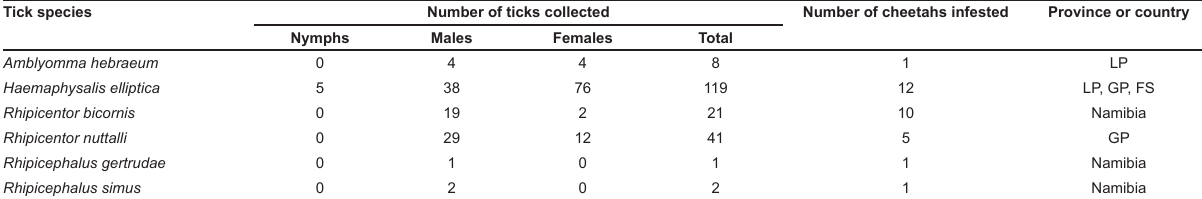
TABLE 2 Ticks collected from 23 cheetahs in South Africa and Namibia